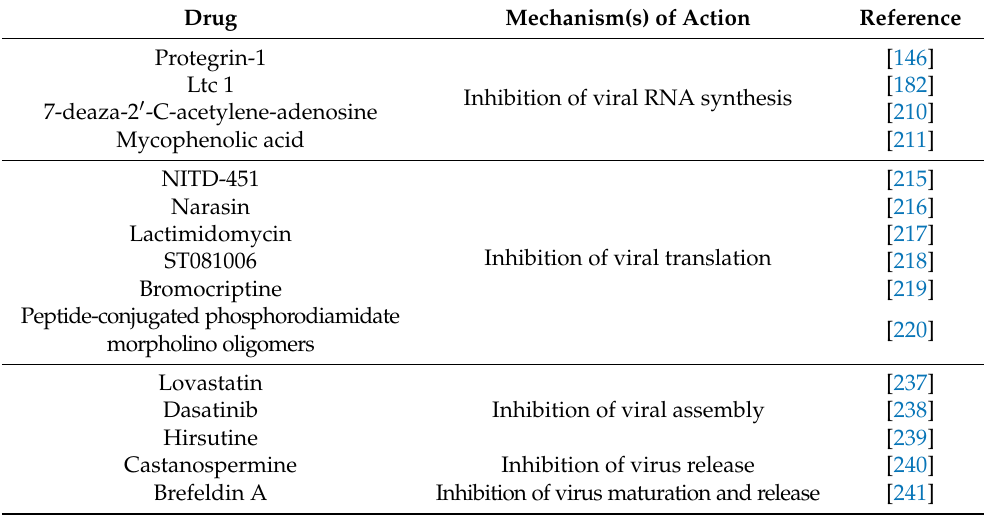
Table 6. DENV antivirals targeting the post-infection stages. Drug Mechanism(s) of Action